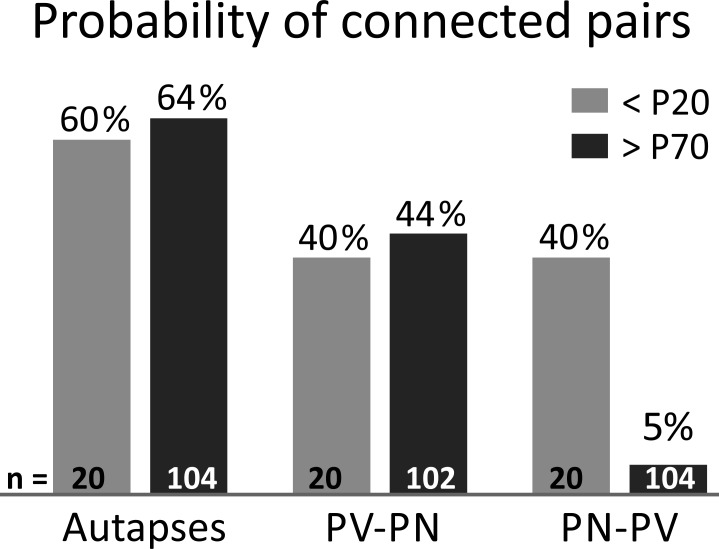
Probability of L4 connected pairs in young and adult mouse V1.Incidence of autaptic neurotransmission are shown in the left part, PV-PN and PN-PV connectivity in the middle and right part, respectively. Grey bars:<P20 mice; Black bars:>P70 mice. Note that glutamatergic synapses onto PV cells are very rare in adult animals (>P70).=number of tested pairs. PV: parvalbumin-positive interneuron. PN: principal neuron.